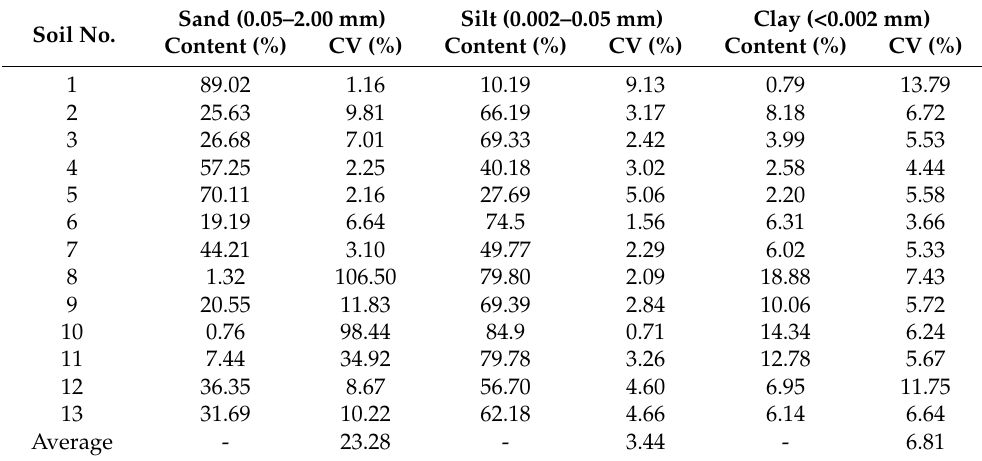
Table 2. Average fraction content with coefficients of variation (CV) from 30 repetitions for each soil. Soil